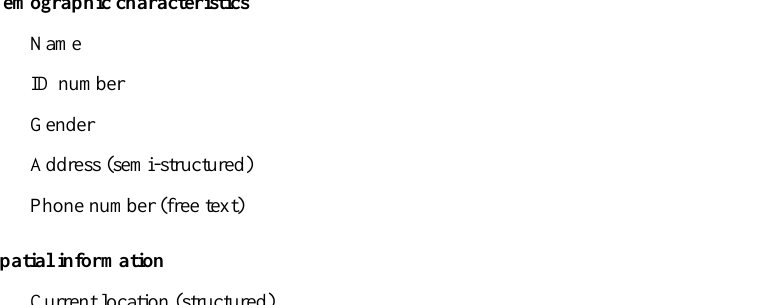
Textbox 1. Real time questionnaire on WeChat. Demographic characteristics